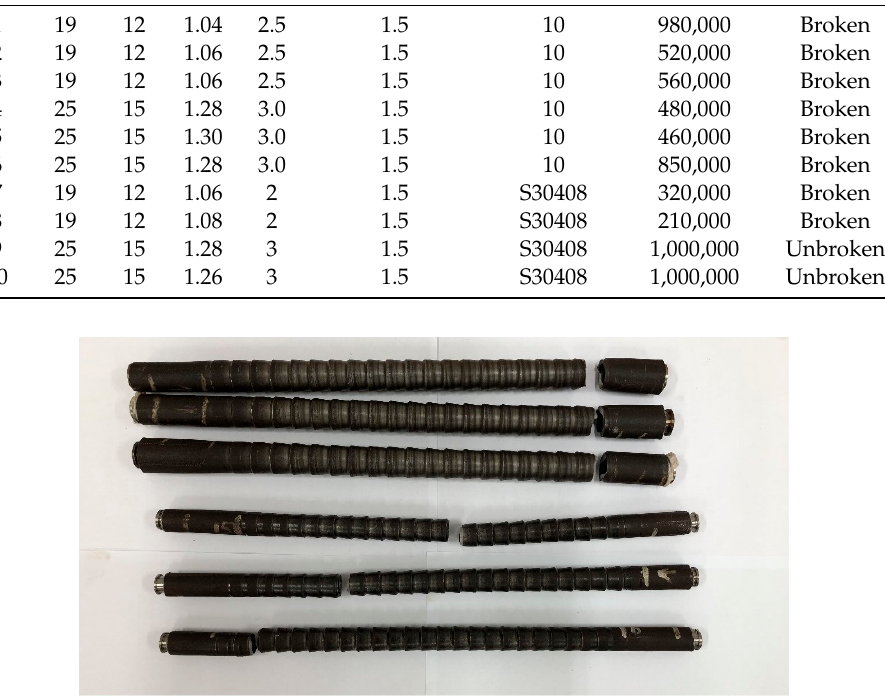
Table 4. Fatigue experimental results of the CD tubes with different sizes and materials. No.